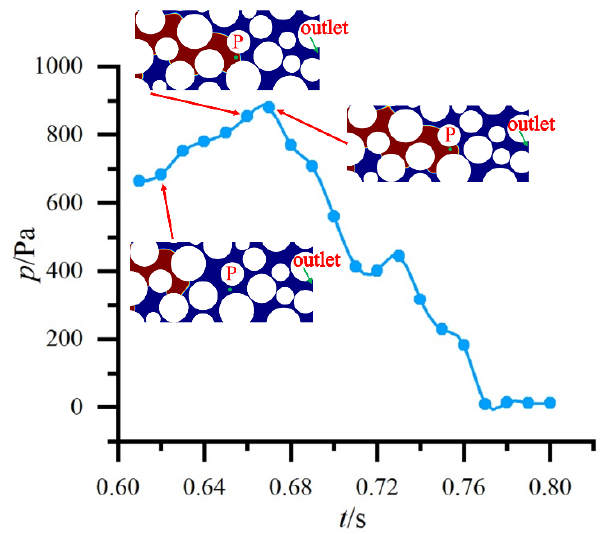
Figure 8. Pressure vs. time at point P near the outlet.